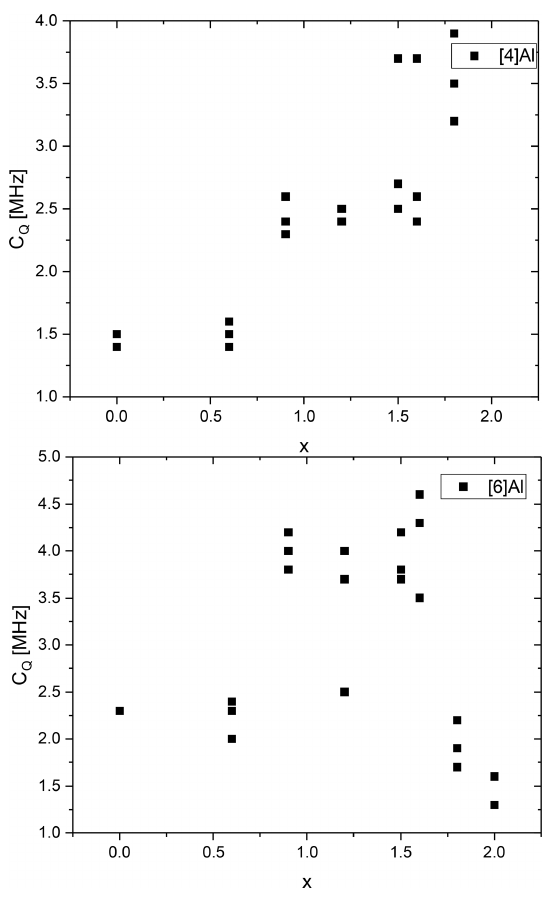
Figure 14. Quadrupolar coupling constants of the 27 Al MAS NMR tetrahedral and octahedral mica resonances with selected nominal compositions of K(Li x Al 2 − x/ 3 (cid:3) 1 − 2 x/ 3 [AlSi 3 O 10 ](OH) y F 2 − y with 0 . 0 ≤ x ≤ 1 . 5 and 0 . 0 ≤ y ≤ 2 . 0 and K(Li x Al 3 − x )[Al 4 − 2 x Si 2 x O 10 ] (OH) y F 2 − y with 1 . 5 ≤ x ≤ 2 . 0 and 0 . 0 ≤ y ≤ 2 .